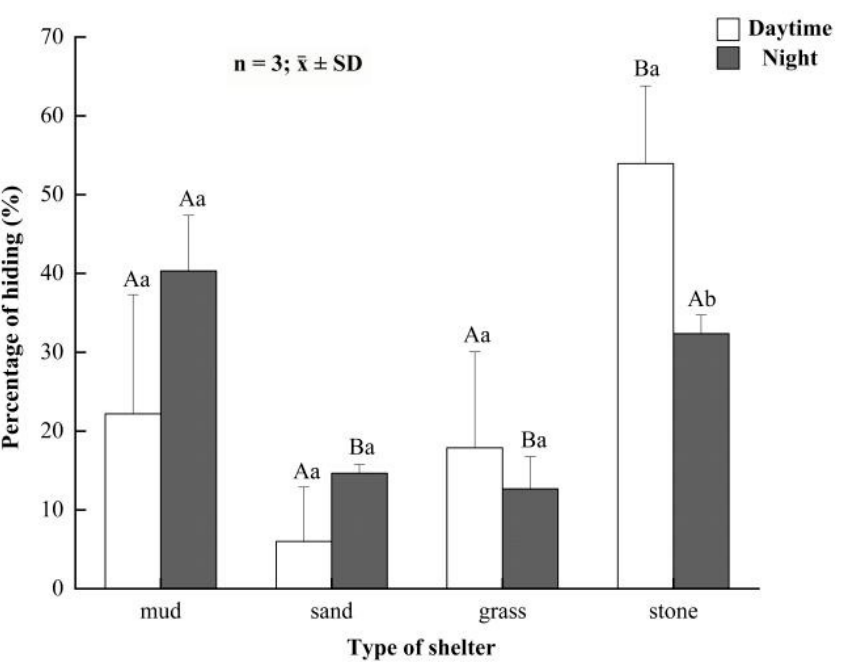
Figure 6. The hiding rate of parent Eriocheir sinensis in different shelters between daytime and night. Bars with same letters on the top indicate they have insignificant differences ( p > 0.05), and bars with different letters on the top indicate they have significant differences ( p < 0.05). Capital letters indicate the significance of hiding rates in different developmental stages, and lowercase letters indicate the significance of hiding and not hiding in the same